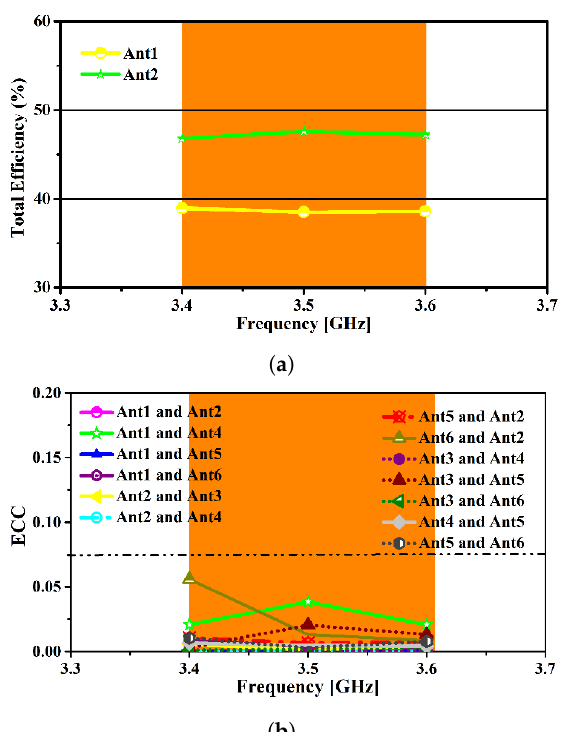
Figure 12. Two-Hand Operation (THO) for the proposed multiple antenna system. ( a ) total efficiency. ( b ) Envelope correlation